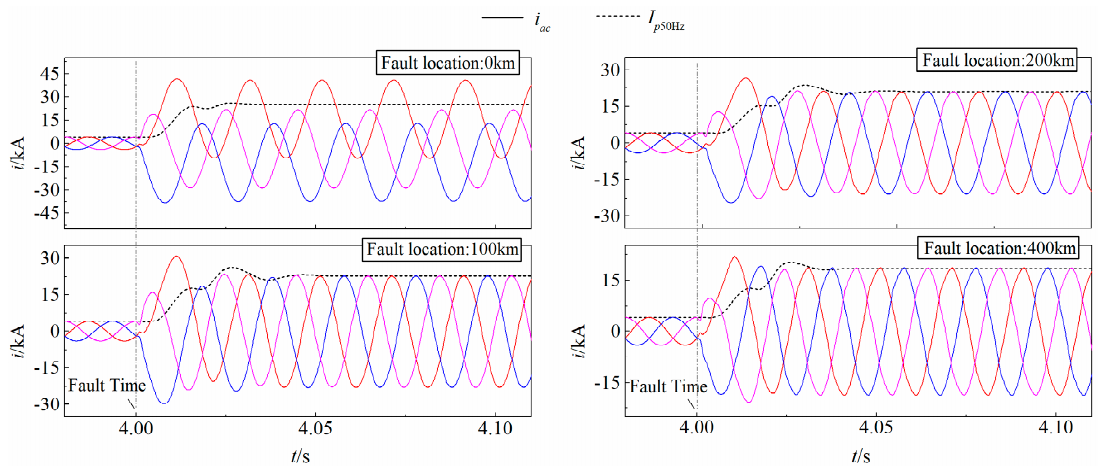
Figure 3. AC current under pole ‐ to ‐ pole faults.